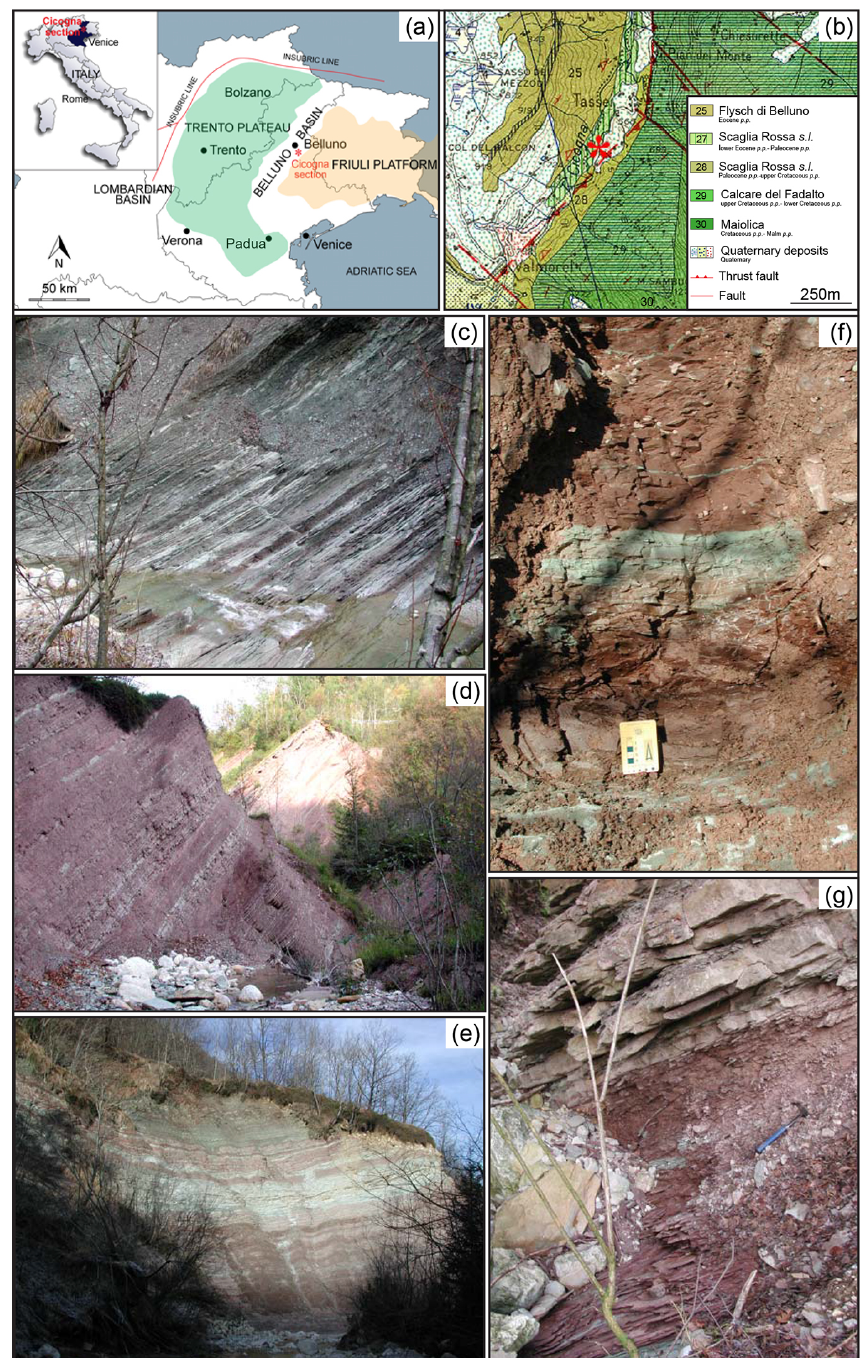
Figure 3. The location and representative photographs of the Cicogna section in northeast Italy. (a) Geographic map showing the main Late Cretaceous–early Paleogene paleogeographic domains of the Italian Southern Alps (modified after Cati et al., 1989); (b) geological map of the local area (modified after Costa et al., 1996, indicating also the location of the Cicogna section; red asterisk); (c) alternating beds of Paleocene gray-green marls and calcareous marls (0–20m); (d) the Scaglia Rossa sensu lato overlain by the Belluno Flysch; (e) marl/calcareous marl couplets in the lower Eocene portion of the section (approximately 40.0–70.0m); (f) the base of the Clay Marl Unit, which denotes the onset of the PETM (approximately 28.7–29.3m); and (g) the brownish-red interval of clayey marls with sporadic gray-green centimeter-scale spots and lenses, the CMU, overlain by prominent rhythmic alternations of marls and calcareous marls (approximately 28.7–33.0m).